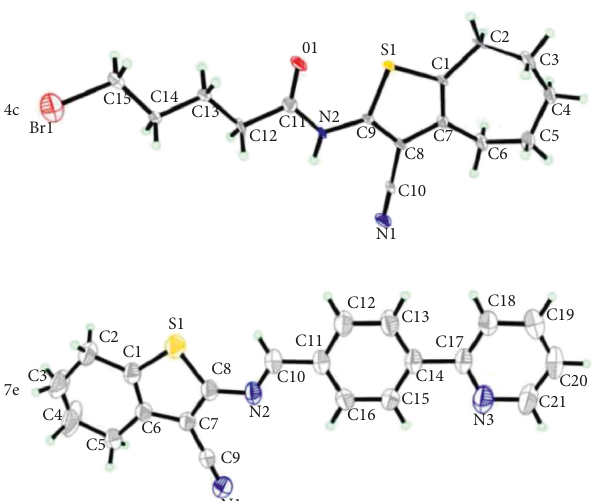
Figure 2: ORTEP diagrams of the titled compounds 4c and 7e . Displacement ellipsoids are plotted at the 40% probability level for non-H atoms. Table 2: The zones of inhibition (mm) of the synthesized compounds and standard antimicrobial drugs. Compound